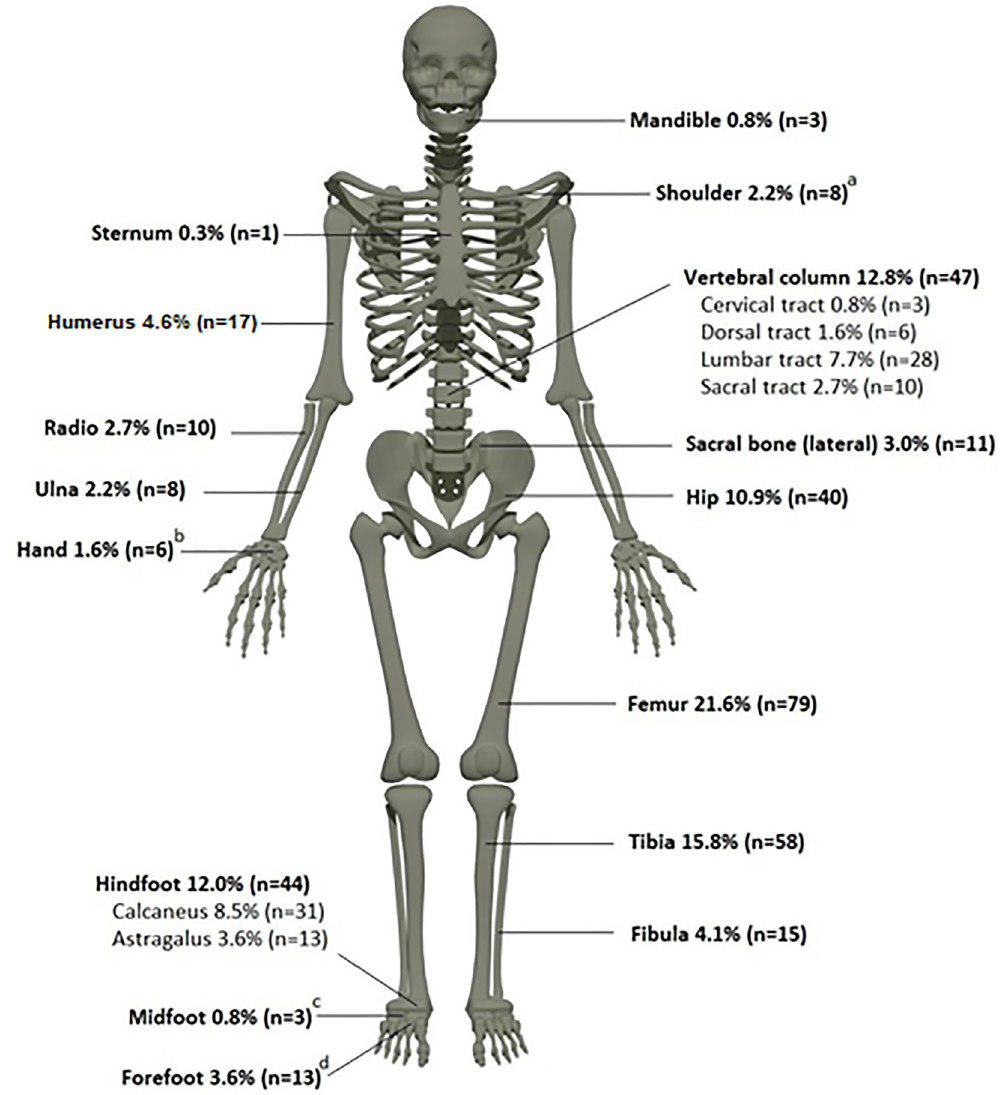
Figure 2. Sites of bone infection Modified from: File:201,805 human skeleton.png. DataBase Center for Life Science (DBCLS), CC BY 4.0 < https:// creat iveco mmons. org/ licen ses/ by/4.0 > , via Wikimedia